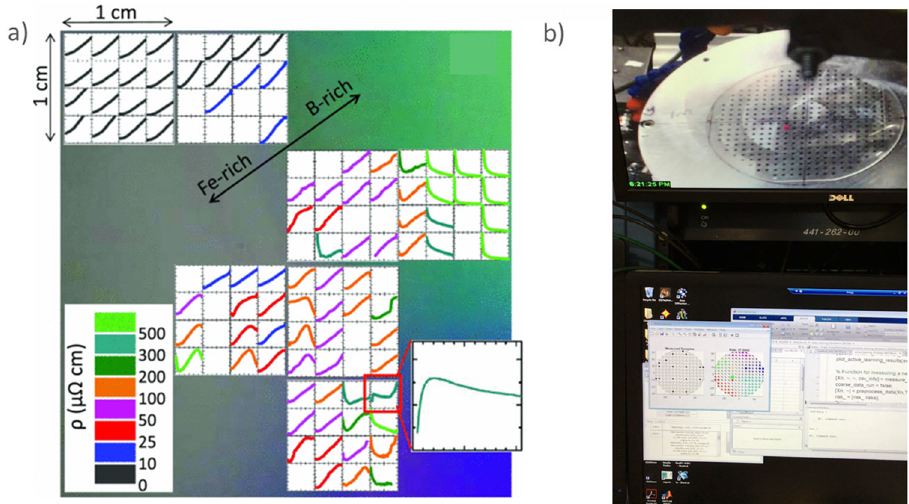
Fig. 4 Accelerating experimental discovery processes. a High-throughput methods can be used to perform validation of predicted materials. Visualization of resistivity vs temperature curves measured at different parts of a Fe-B composition spread. The horizontal range of each curve covers 2 – 300 K. The resistivity range for each curve is color coded (reproduced from ref. 141 under the terms of the Creative Commons CC BY license); b On-the- fl y analysis of synchrotron diffraction data 124 . A snapshot photo from the experiment. The upper screen shows the scanning stage with a thin- fi lm library inside a beamline hutch. The bottom screen is a laptop, where unsupervised ML of diffraction patterns is carried out after each measurement. The same setup has also been used to carry out active-learning-based autonomous